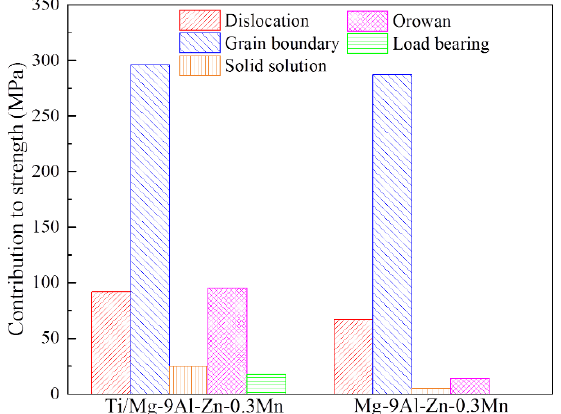
Figure 14. The contribution to strength from different strengthening mechanisms.